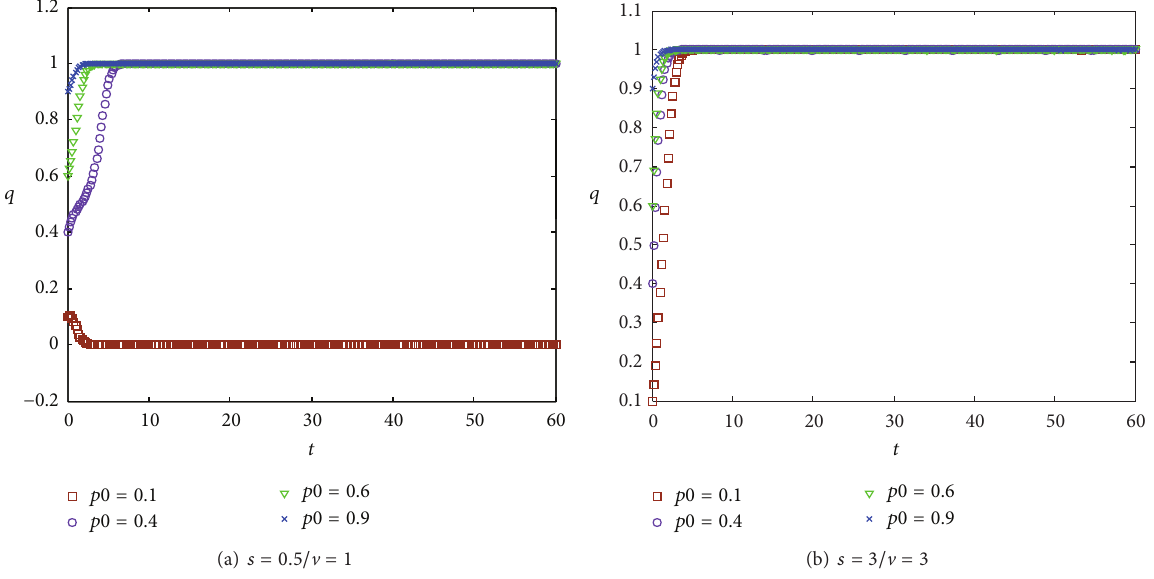
Figure 7: The influence of the consumers’ positive guidance on the cooperation strategy.